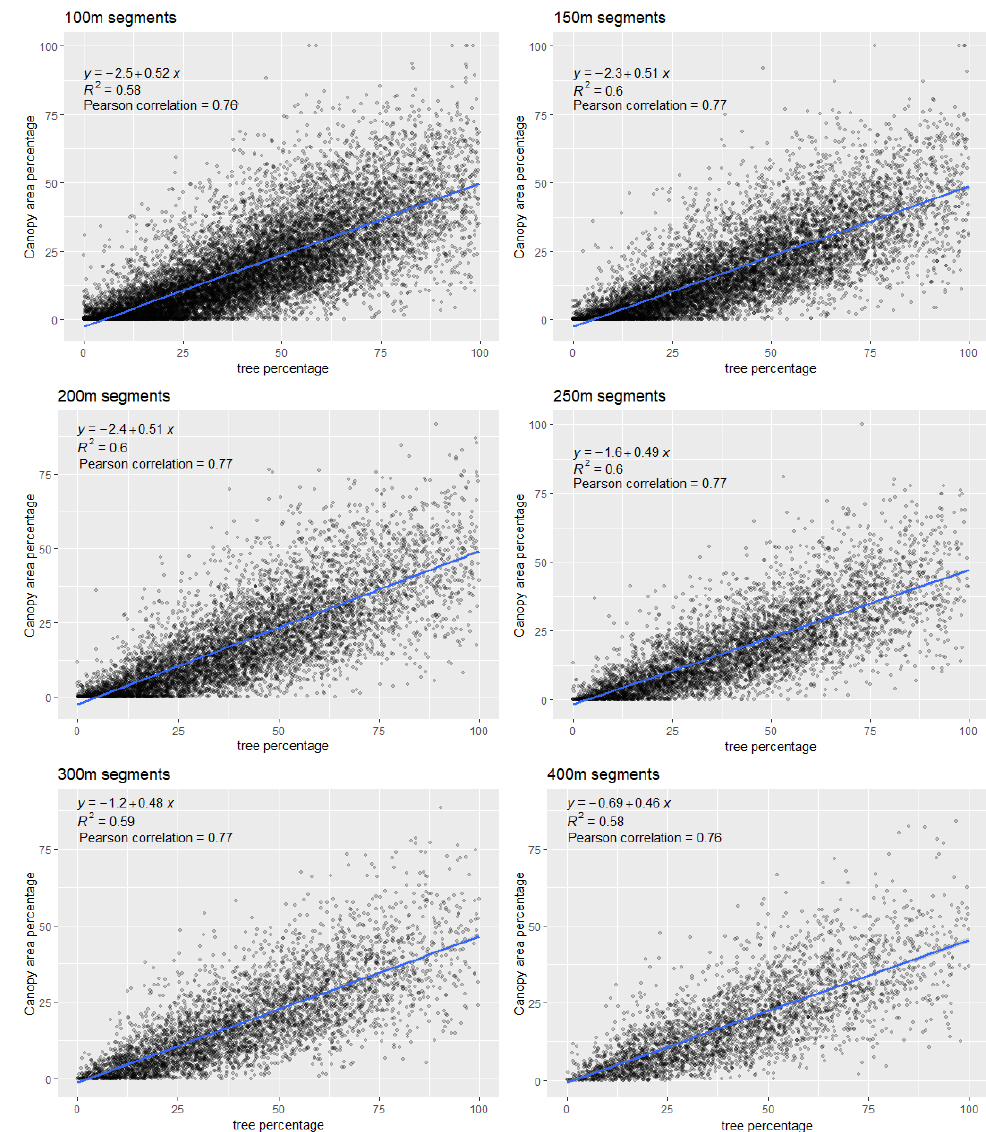
Figure 9. Greenness and canopy